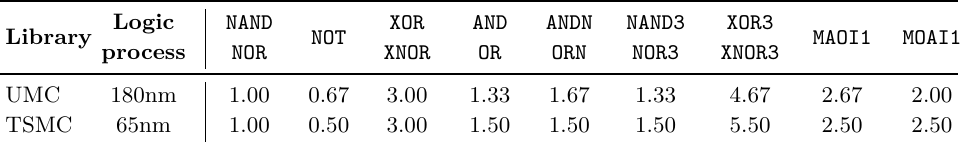
Table 8: Comparisons of several standard cell libraries for typical combinatorial cells. The values are given in GE.